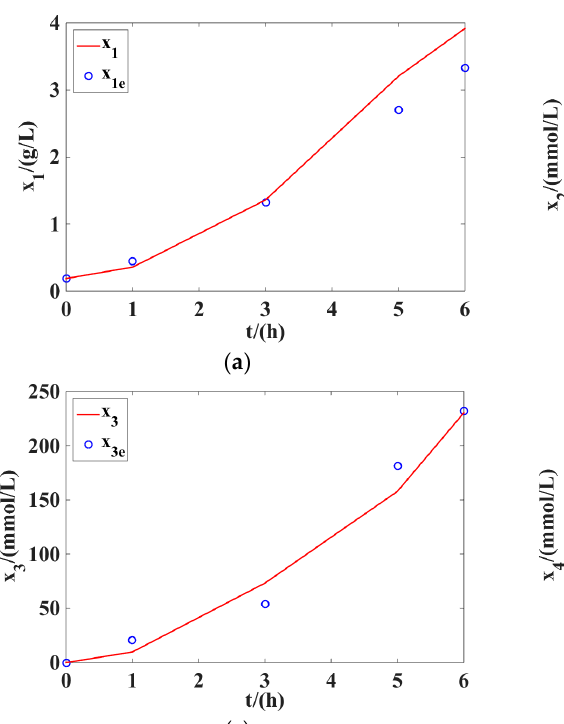
Figure 2. Comparison between the computed values and the experimental data in the proposed two-stage method: ( a ) biomass; ( b ) substrate glycerol; ( c ) 1,3-propanediol (1,3-PD); ( d ) acetic acid; ( e ) ethanol.